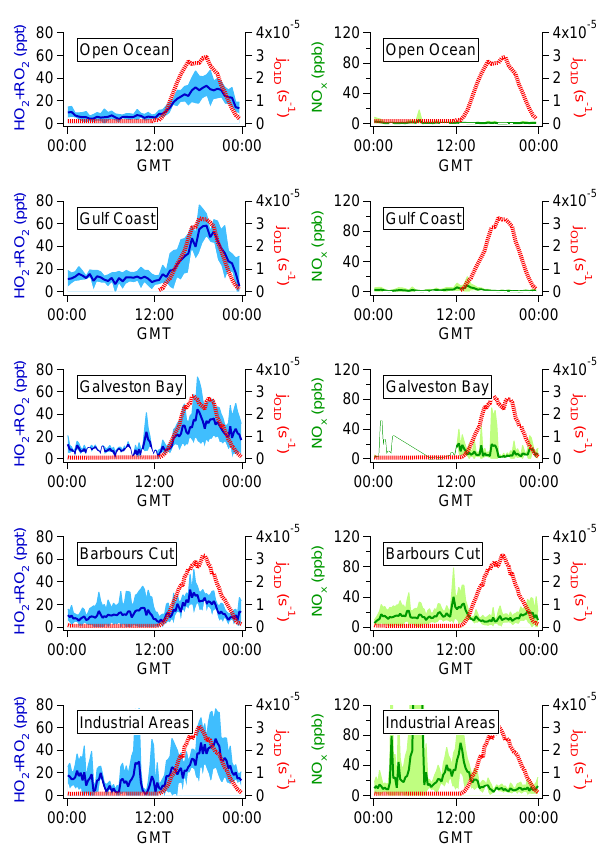
Fig. 5. Average diurnal profiles of HO 2 + ΣRO 2 (in blue), NO x (in green) and j ( O 1 D ) (in red) at different locations during the R/V Brown cruise. The shading corrsponds to 1- σ . 34